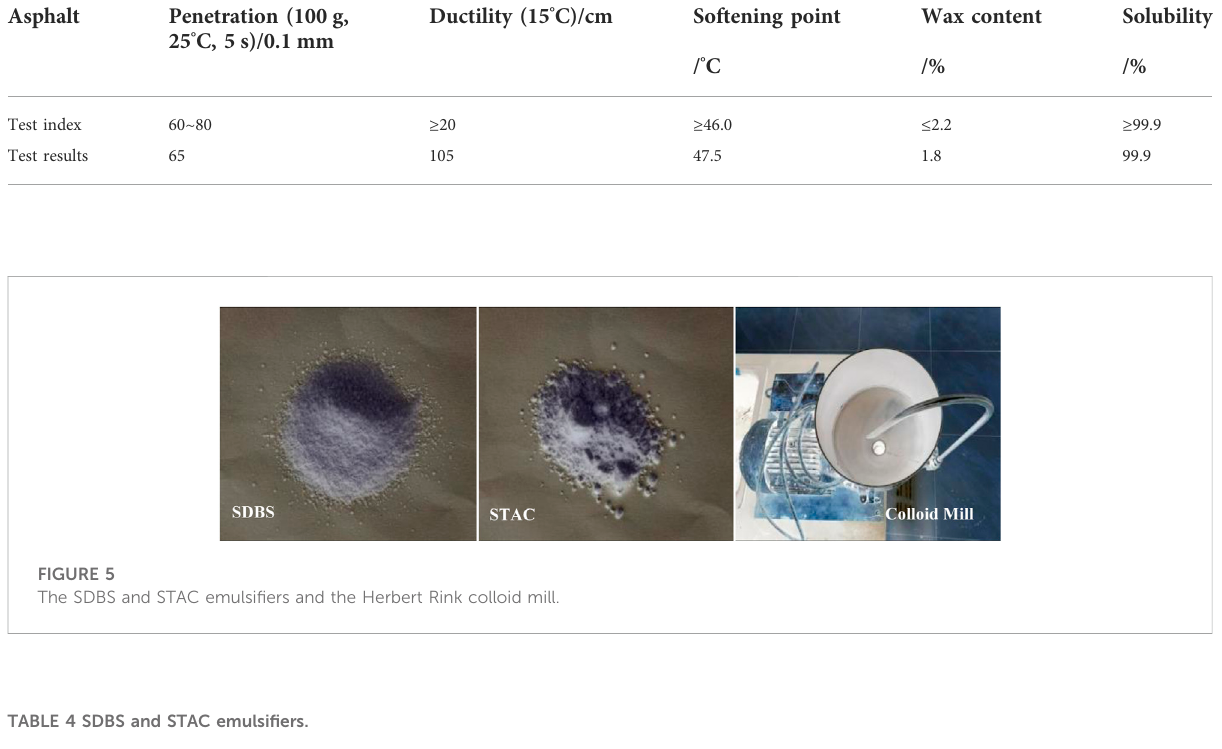
TABLE 4 SDBS and STAC emulsi fi